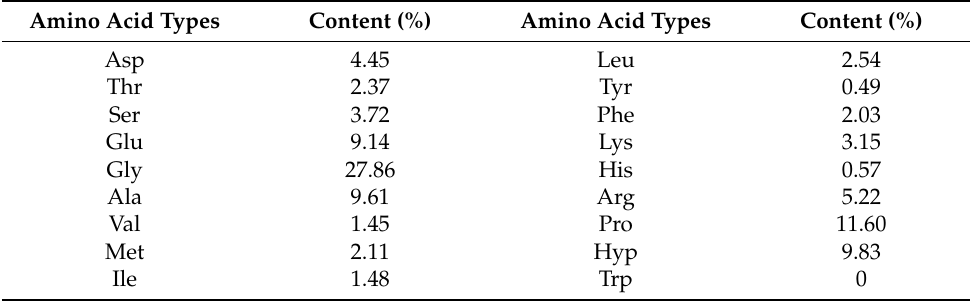
Table 1. The amino acid composition of chicken bone